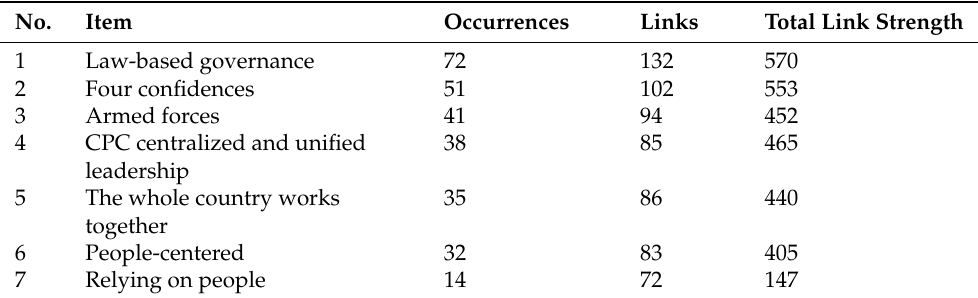
Table 5. Keyword statistics of the institutional strengths employed in the COVID-19 prevention and control